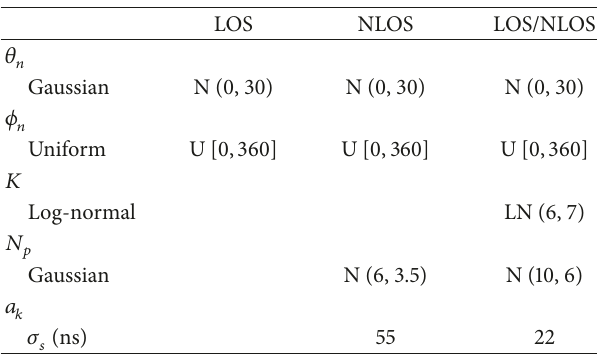
Table 1: Propagation environment